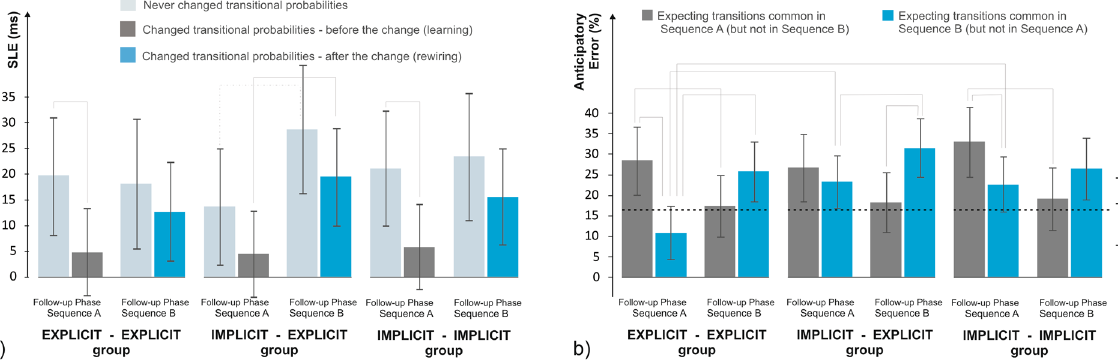
Figure 3. Testing the efficiency of the rewiring process after a 24-hour consolidation period, in the Follow-up Phase. ( a ) Overall, SLEs for the changed sequence parts (dark grey and blue bars) were smaller than that of the unchanged sequence parts (light grey bars). In the case of the changed sequence parts, statistical structure that corresponded to Sequence B (that was learned in the Rewiring Phase) was retained better than statistical structure that corresponded to Sequence A (that was learned in the Learning Phase) – the latter not reliably differing from zero (as shown by 95% CIs). This pattern indicates adaptation to the changed statistical regularities of Sequence B taking place in the Rewiring Phase, and no observable proactive interference of Sequence A, thus, overall successful rewiring. No group differences were observed. ( b ) Chance level for anticipatory errors are shown by the dotted line. Each group showed adaptation to the current sequence as anticipations for Sequence A were above chance level when performing Sequence A in the Follow-up Phase; while anticipations for Sequence B were above chance level when performing Sequence B. This pattern suggests that the old and new knowledge, acquired on the first and second day of the experiment, coexisted after a 24- hour delay period, and were accessible when required. The solid lines connecting the bars indicate significant differences ( p < 0.05). Dotted lines indicate trend level differences ( p < 0.10). Error bars represent 95%